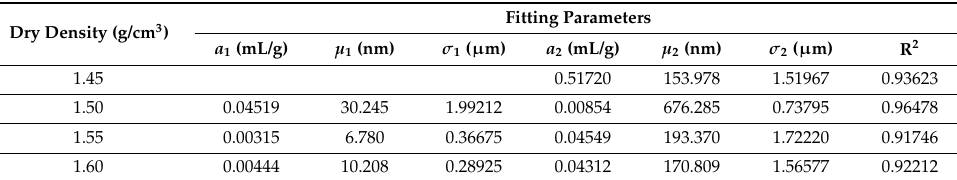
Figure 3. Gaussian function fitting results for samples with different dry densities. Table 3. Soil sample Gaussian fitting parameters.